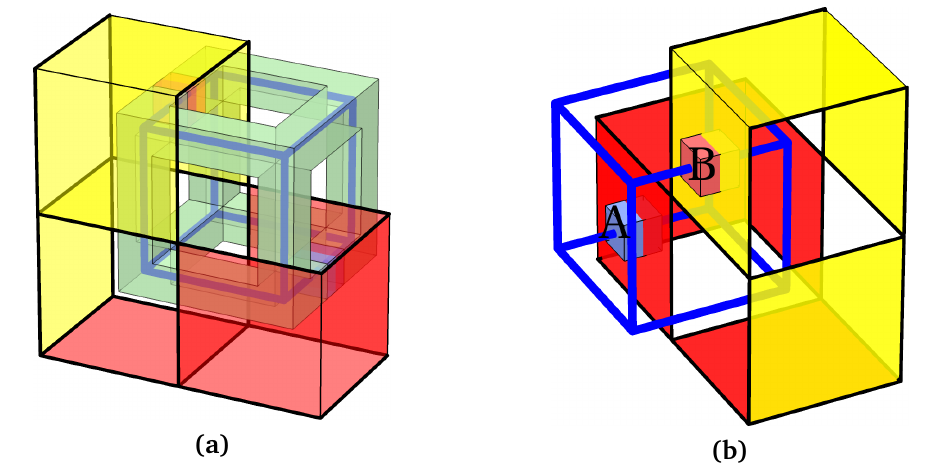
Figure 5: Operators satisfying the conditions of Eq. (13) which can be used to bound I ( A ; B | C ) for the cubic scheme depicted in Fig. 3(a). (a) For the X-cube model (Fig. 7(c)), I ( A ; B | C ) ≥ 1 is obtained by taking W to be a product of X operators 1 along the blue lines, and U and U def to be products of Z operators over all links 1 1 that penetrate the red and yellow regions, respectively. For the checkerboard model (Fig. 7(d)), I ( A ; B | C ) ≥ 2 can be obtained by taking W ( W ) to be a product of X ( Z ) 1 2 operators along the blue lines, and U and U def ( U and U def ) to be products of Z ( X ) 1 2 1 2 operators over the red and yellow surfaces, respectively. I ( A ; B | C ) ≥ 1 can similarly be obtained for the Chamon model (Fig. 7(e)) using a tetrahedal-shaped geometry, but each operator will contain a mix of X , Y , and Z Pauli operators. (b) Another view with subsystem C (green) hidden for